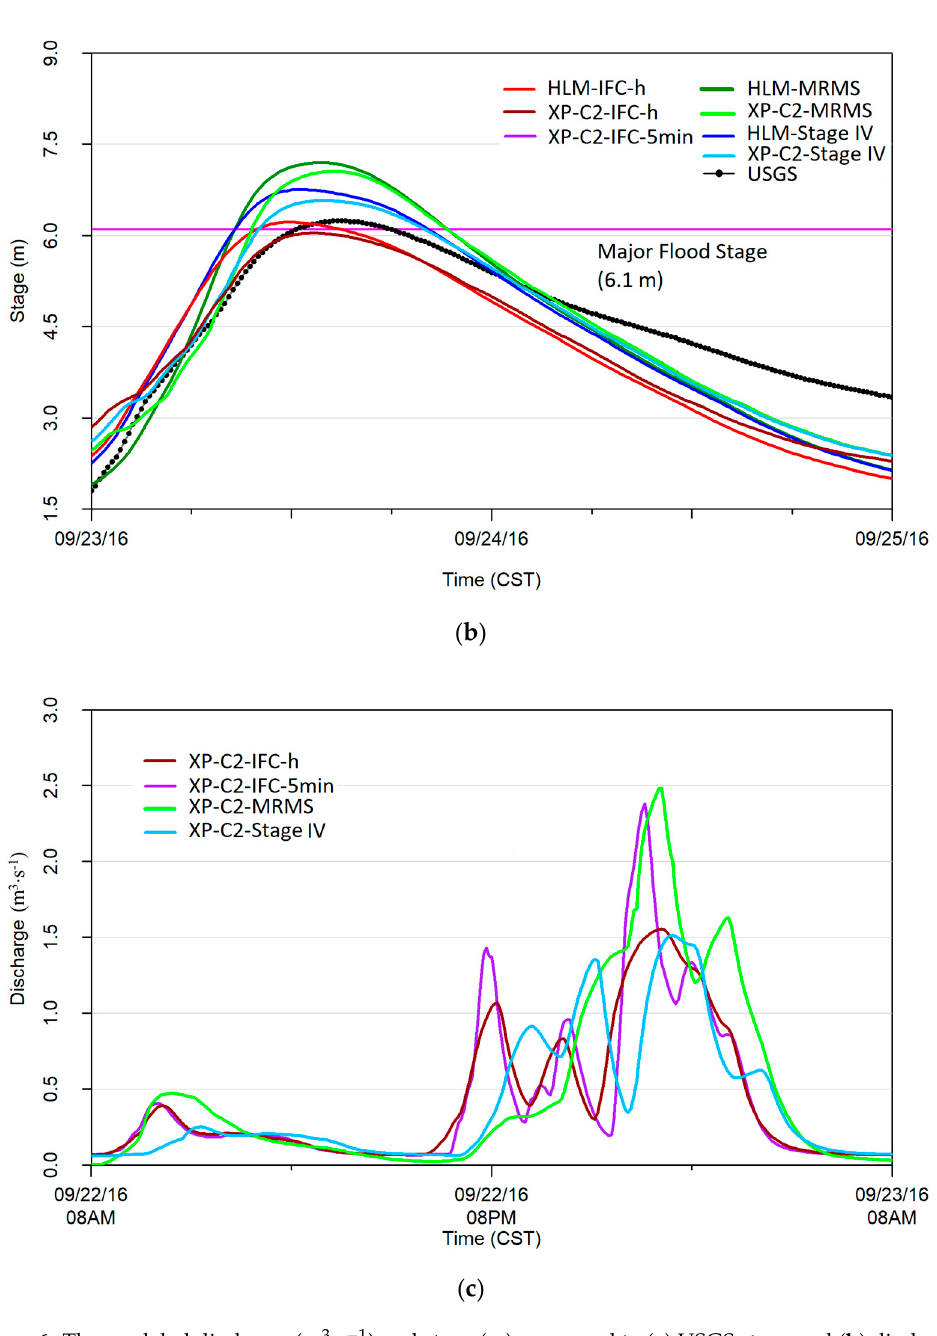
Figure 6. The modeled discharge (m 3 ⋅ s − 1 ) and stage (m) compared to ( a ) USGS stage and ( b ) discharge observations for September 2016. The simulated hydrographs are named according to the model (HLM or XP—C2) and the radar rainfall input. The models forced with the IFC hourly radar rainfall product are red (HLM—IFC—h, XP—C2—IFC—h, XP—C2—IFC—5min) while those forced with Stage IV hourly radar rainfall are blue (HLM—Stage IV and XP—C2—Stage IV). Models forced with MRMS hourly radar rainfall are colored green (HLM—MRMS and XP—C2—MRMS). ( c ) The discharge from the Eastern Tributary, which drains the eastern domain of the XPSWMM model, shows how the hydrological response of Manchester is significantly impacted by the spatial and temporal resolution of the radar rainfall input.